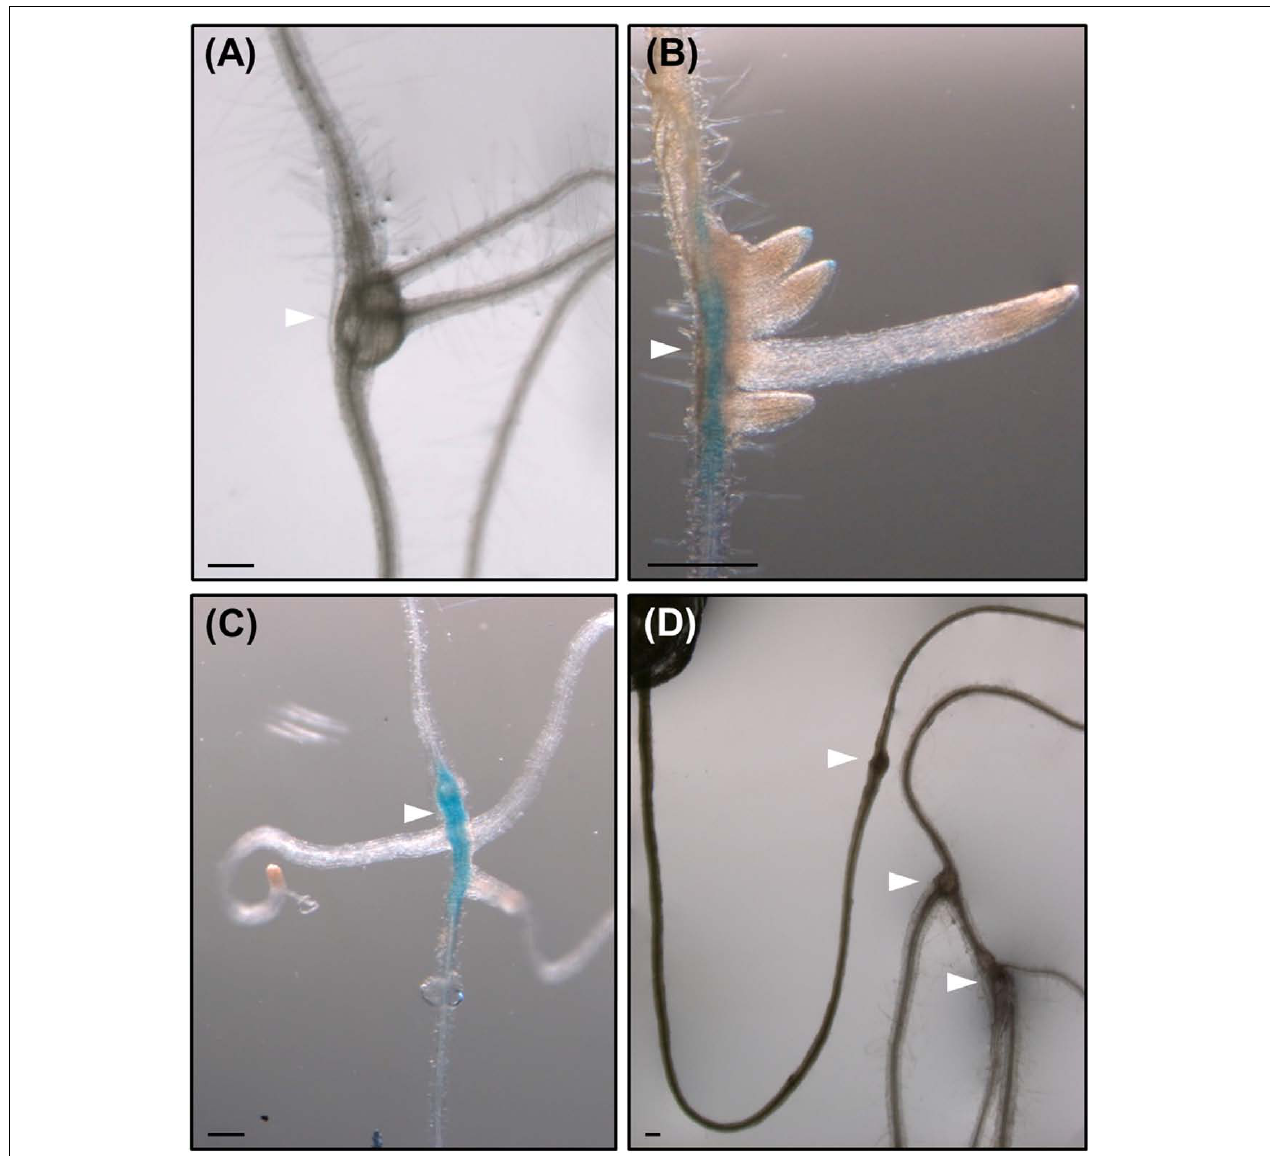
FIGURE 6 | Root-knot nematodes galls induced in roots of lateral root (LR) impaired mutant lines, show de novo organogenesis of non-canonical LRs as well as in wild type plants. Emergence of LRs-like structures with no alternate pattern from galls induced by M. javanica in Col 0 (A) , in arf7/arf19 (B) , and slr (C) mutants expressing pLBD16::GUS, and in alf4 (D) mutant. White arrow heads indicate the galls. Scale Bars: 200 µ